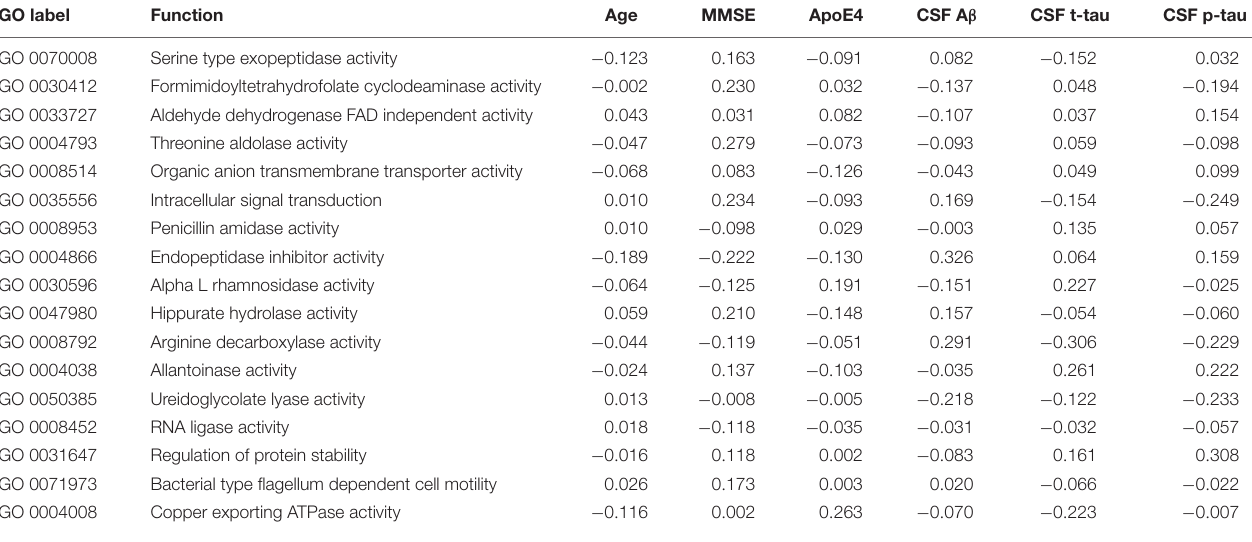
TABLE 6 | The associations between GO (Gene Ontology) features and Alzheimer’s disease (AD) clinical and biomarker